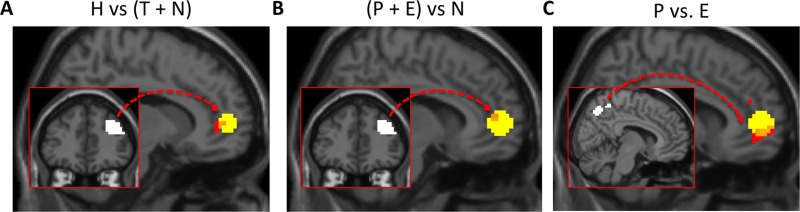
Exploratory functional connectivity analyses.(A) Region of the VMPFC (red) where increased connectivity with the DLPFC during Health vs. Natural and Taste focus conditions correlates with Δw Healthiness in Health vs. Natural and Taste Focus. The yellow region shows the VMPFC ROI defined by the conjunction of all attributes. Orange indicates overlap. Inset: DLPFC seed region. (B) Region of the VMPFC (red) where decreased connectivity with the DLPFC during Partner and Ethics conditions compared to Natural predicted decreases in Δw $Self in Partner and Ethics vs. Natural condition. The yellow region shows the VMPFC ROI defined by the conjunction of all attributes. Inset: DLPFC seed region. (C) Region of the Precuneus where increased connectivity with the VMPFC during Partner vs. Ethics conditions Δw $Other weight in Partner vs. Ethics trials. Yellow region shows the VMPFC ROI defined by the conjunction of all attributes. Inset: Precuneus seed region. All results are shown thresholded at p < 0.005 uncorrected.